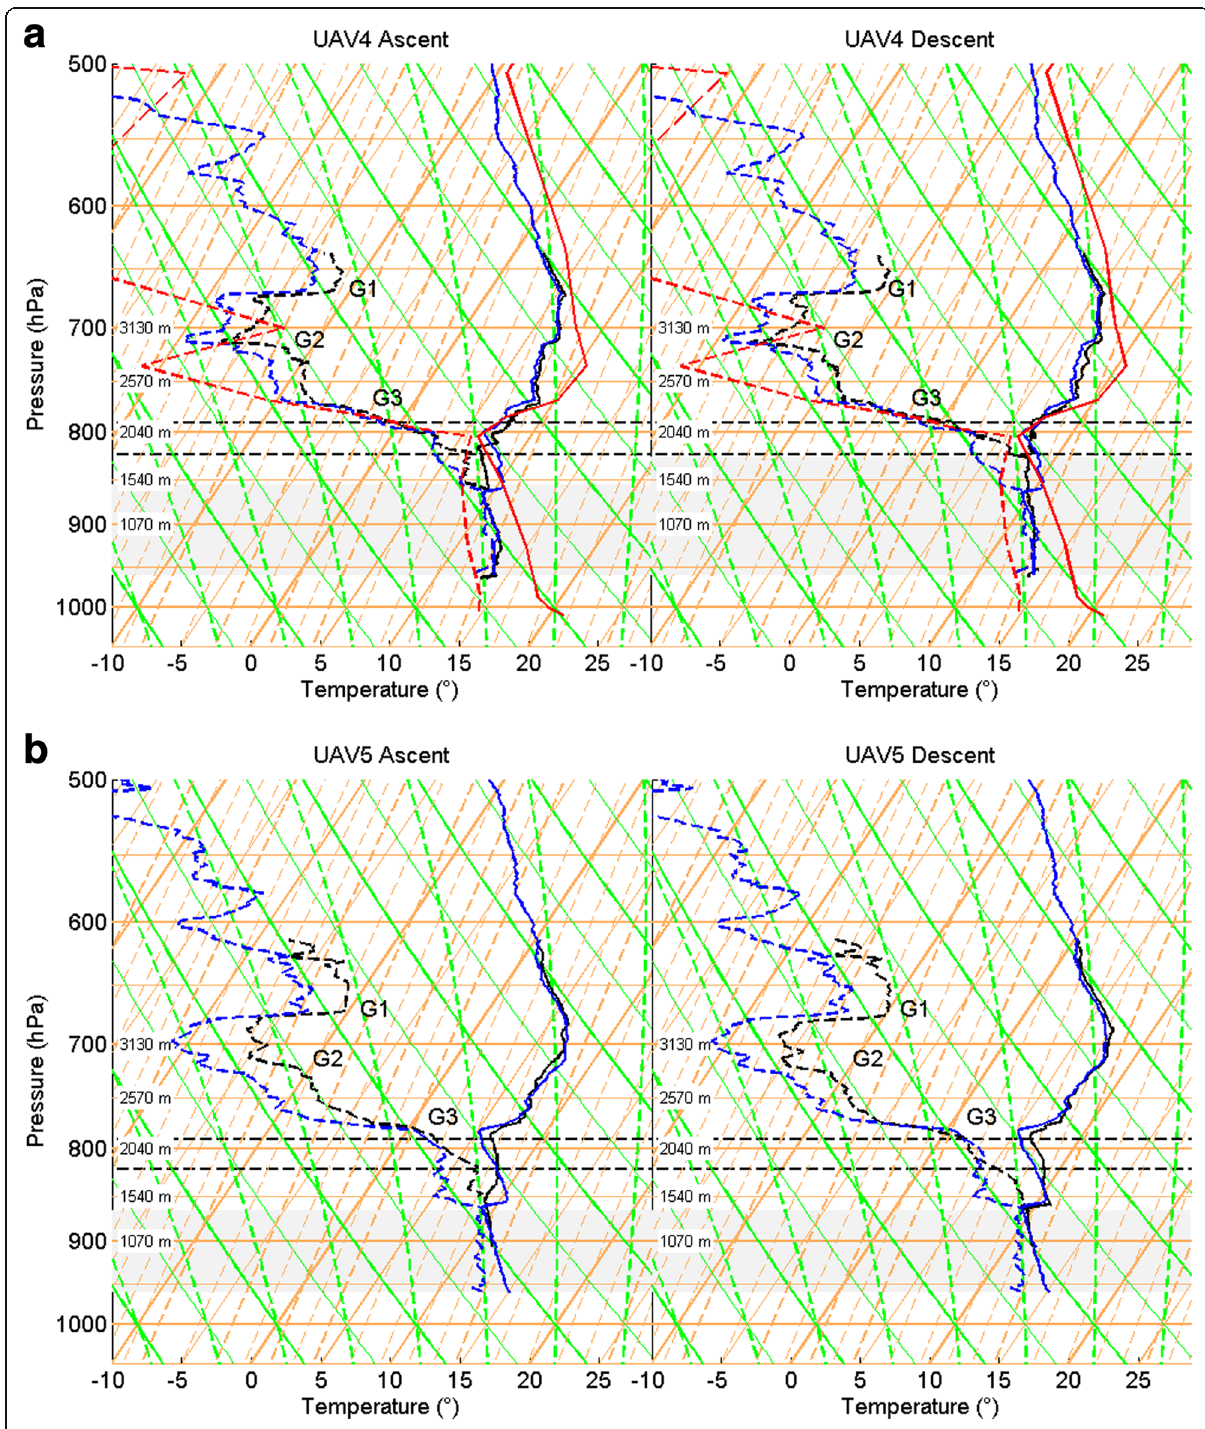
Fig. 3 a Thermodynamic diagrams showing temperature (solid lines) and dew-point temperature (dashed lines) profiles for UAV4 (black), B1 (blue), and for a balloon (red) launched on 7 June 2015 09:00 LT from Shionomisaki station, about 160 km south of the MU radar site. The left (right) panel shows UAV4 ascent (descent) profile. The B1 profiles are the same for both panels. The solid (dashed) green isolines show potential temperature and moist saturated potential temperature, respectively. G1, G2, and G3 refer to moisture gradients discussed in the text. The two horizontal dashed lines delineate the KH region (2) between the altitudes of 1.80 and 2.15 km. b As Fig. 3a, but for B2 and